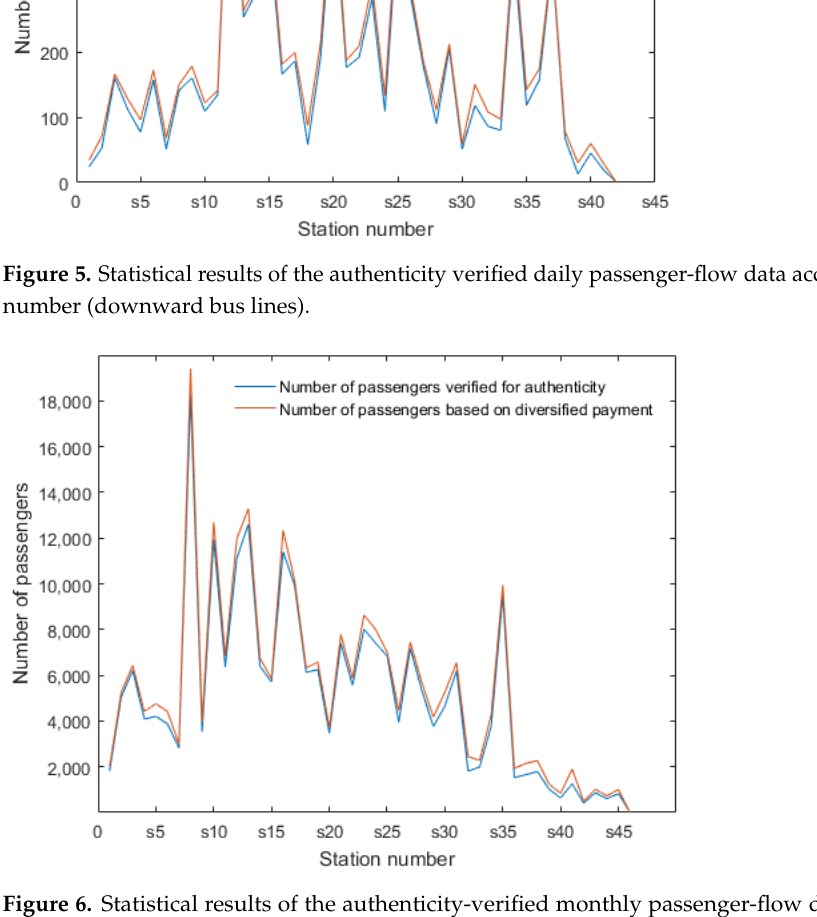
Figure 6. Statistical results of the authenticity-verified monthly passenger-flow data according to station number (upward bus lines).